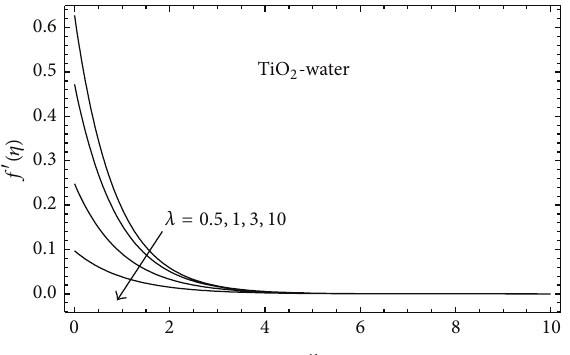
Figure 1: Effect of 𝑀 on velocity distribution 𝑓 󸀠 (𝜂) for Pr = 6.2 and 𝜙 = 0.1 .